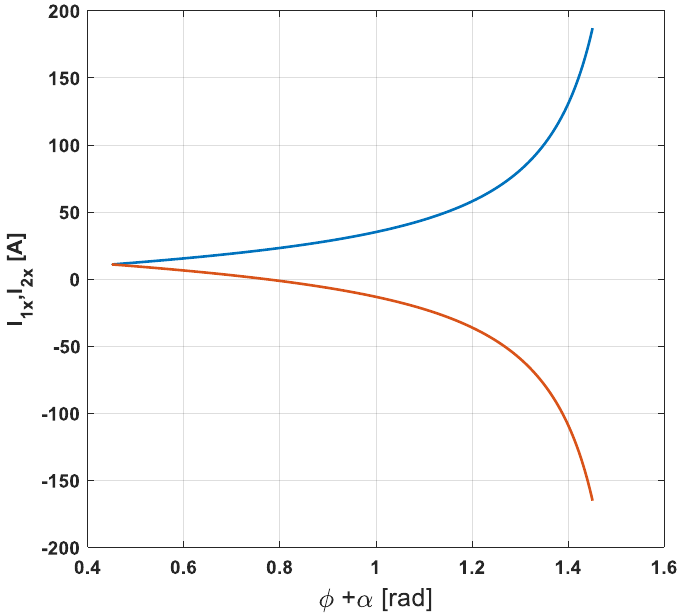
Figure 4. The dependence of the reactive currents I 1 x and I 2 x of the generators on the phase shift between the current of the first generator and the load voltage ( φ + α ).